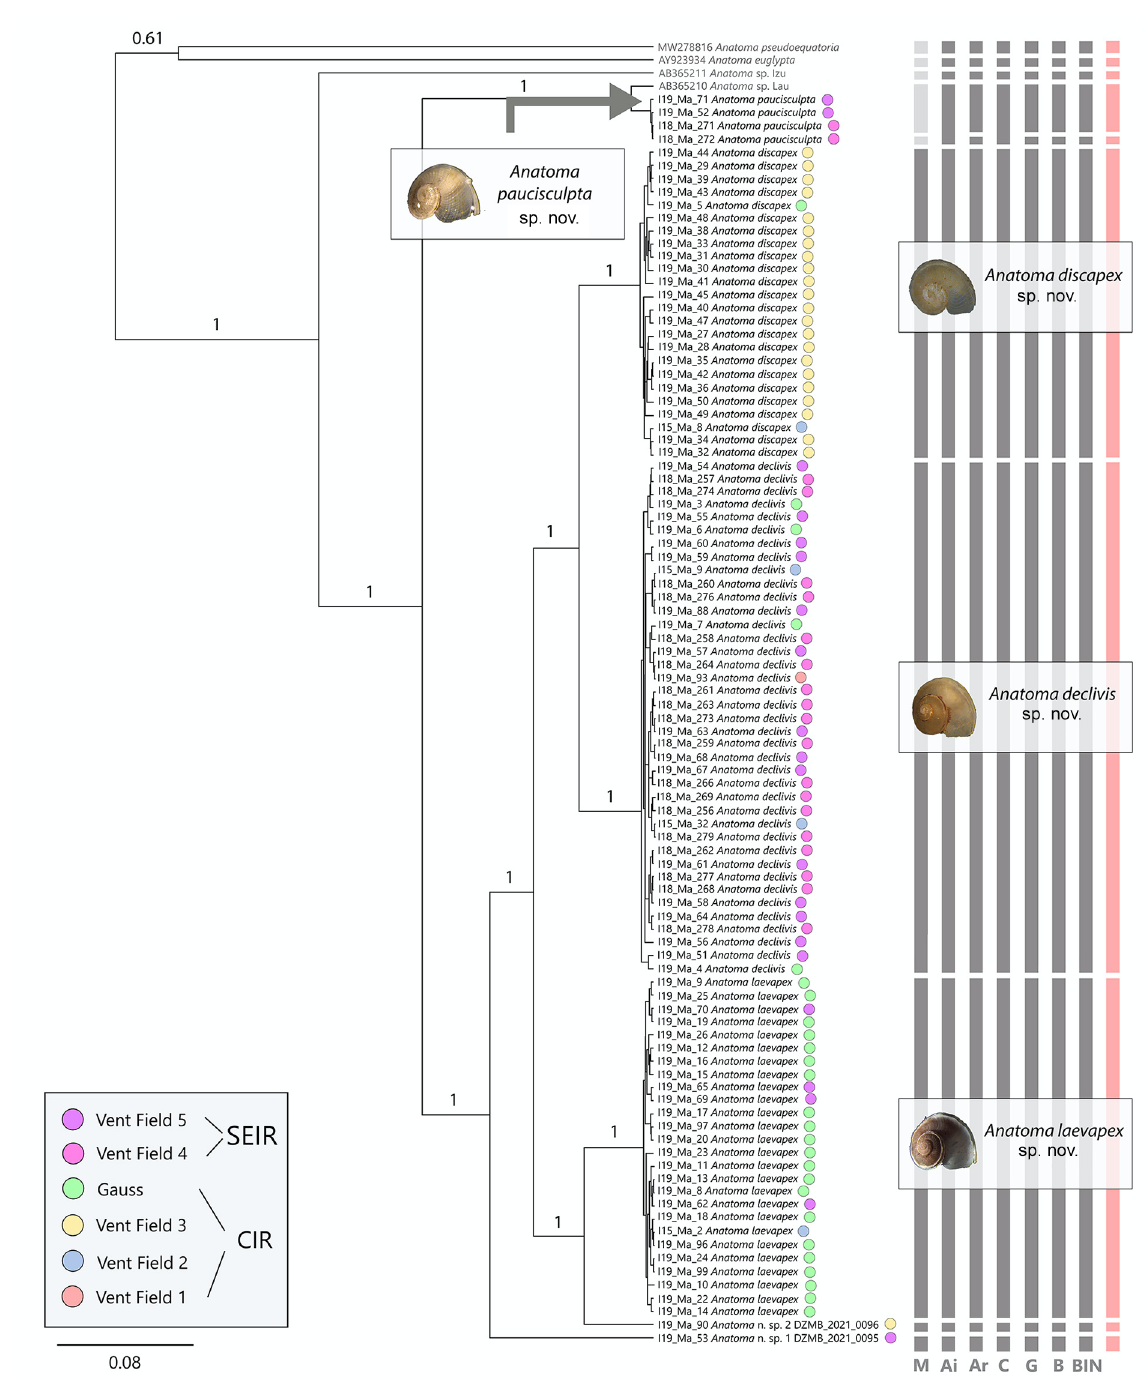
Fig. 2. Bayesian inference tree of 95 individuals based on a MAFFT alignment showing posterior probabilities. Included are four COI sequences from GenBank (marked in grey, Table 2), locations of findings are colour coded. Relevant species delimitation result is shown by six bars: M = morphology; Ai = ABGD (initial partition); Ar = ABGD (recursive partition); C = CD-Hit; G = GMYC; B = BPTP and BIN. The red bar presents the consensus of all delimitation